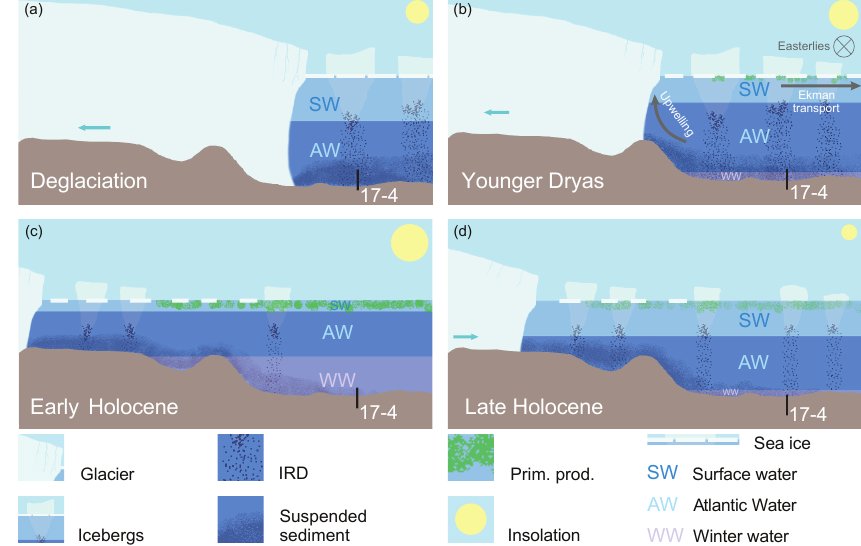
Figure 9. Environmental conditions in Woodfjorden during (a) the deglaciation, (b) the Younger Dryas, (c) the early Holocene and (d) the late Holocene. Black bars mark the location of sediment core GeoB10817-4. Glacier retreats or advances are marked by turquoise arrows. Yellow circles symbolize insolation changes (Berger and Loutre, 1991). The crossed circle in (b) signifies easterlies (blowing perpendicular to the profile) triggering a northward Ekman transport of the surface waters, which entailed an upwelling of intermediate waters (i.e. AW; see Lind and Ingvaldsen,